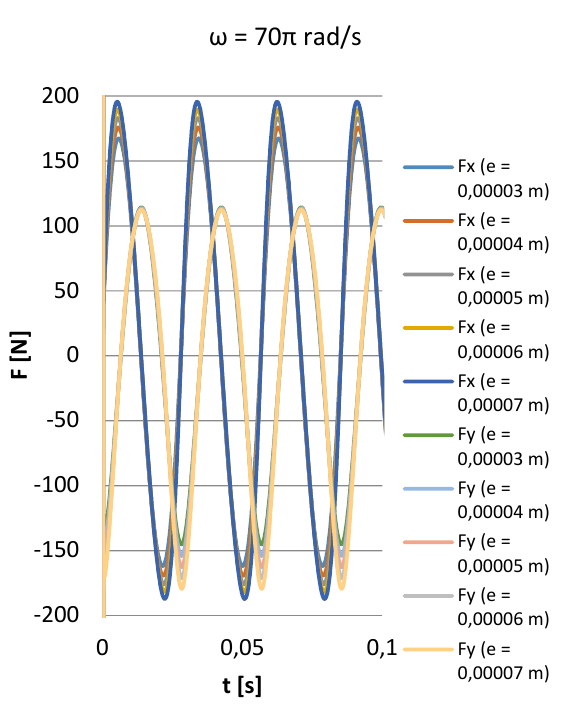
Fig. 5. Force components for ω = 70 π rad/s